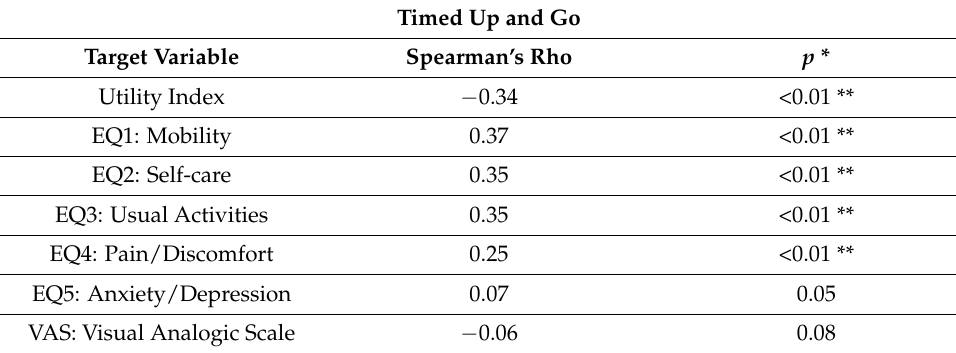
Table 1. Correlation between Timed Up and Go test and EQ-5D-3L in physically active older women with depression ( n =